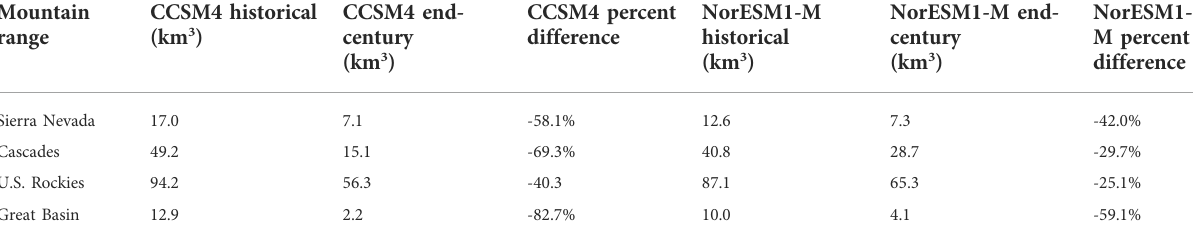
TABLE 3 Maximum snow water storage (SWS) for western U.S. mountain ranges from CCSM and NorESM downscaled